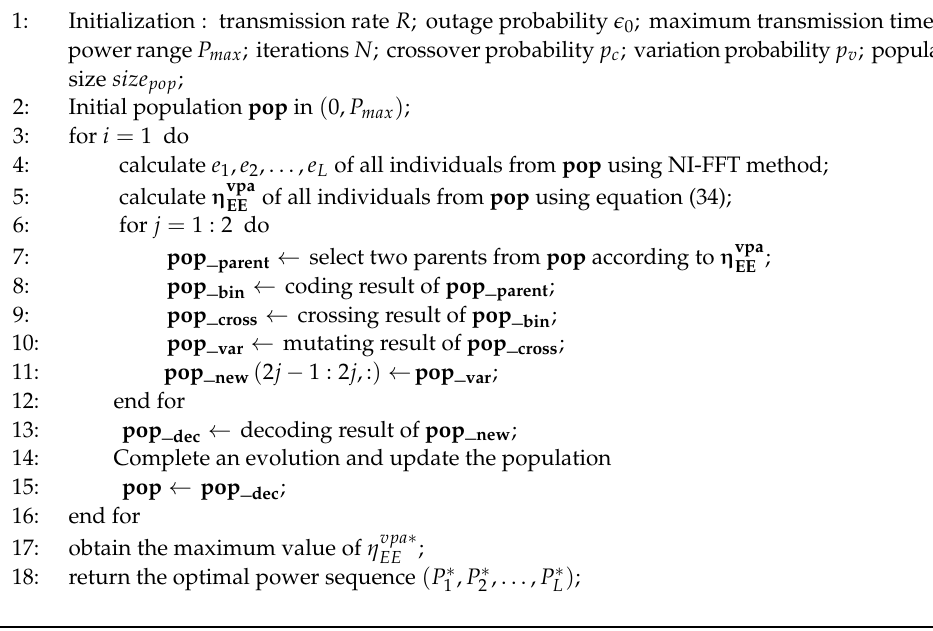
Algorithm 1 Variable power allocation based on the